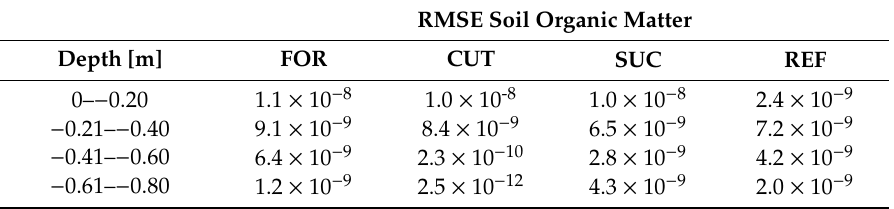
Table 10. Root mean square error (RMSE), interpolated raster soil organic matter.